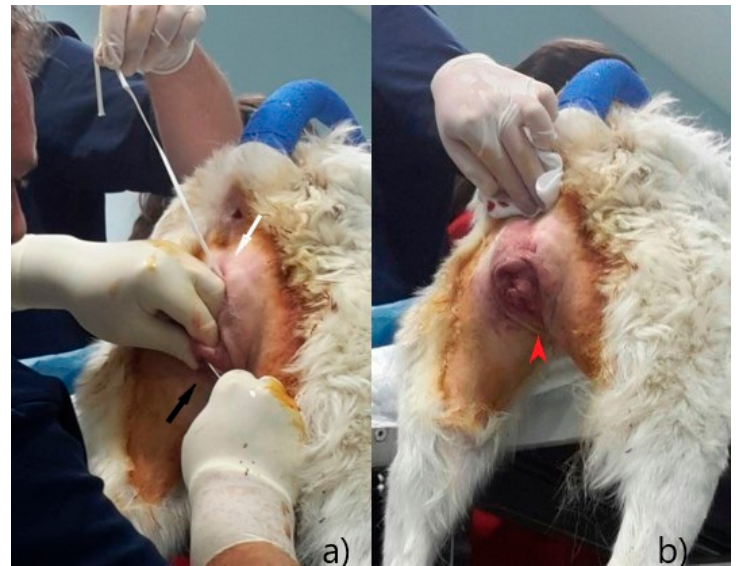
Figure 5 . Bühner technique: ( a ) place the Gerlach needle into the ventral incision (black arrow) and push it through the subcutaneous tissue, laterally to the vulva, exiting at the dorsal incision (white arrow); thread the dorsal free end of the tape into the eyelet of the needle and pull it back, through the subcutaneous tissue so that the tape loops surrounding vulvar labia; ( b ) tie a knot with the vaginal tape exiting the ventral incision (red arrow); reduce the vulvar opening up to allowing proper urination.